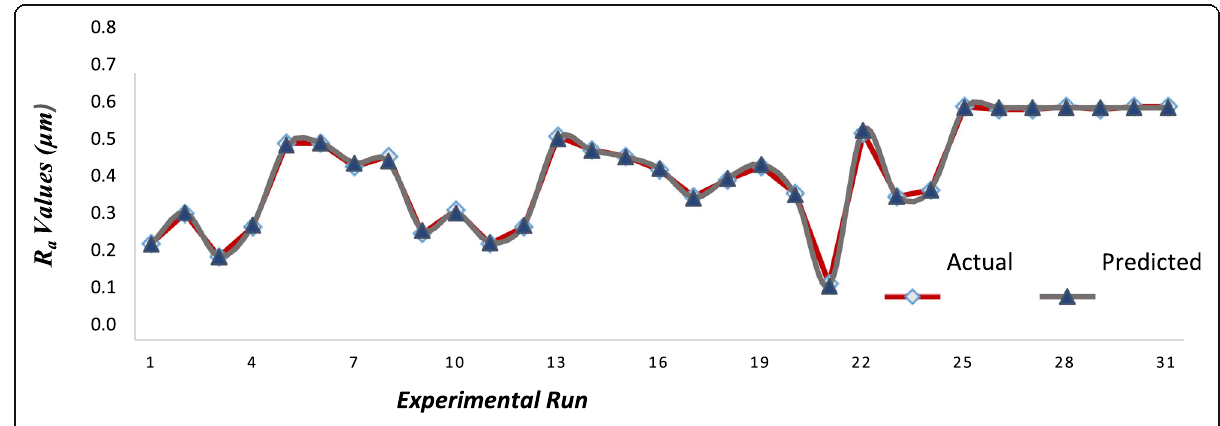
Fig. 6 The comparison between measured and predicted value for the roughness value ( R a